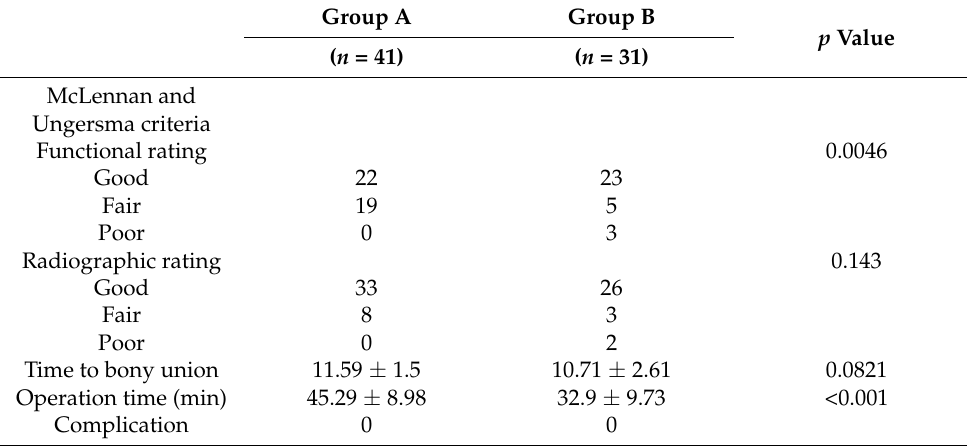
Table 3. Comparison of outcomes between two groups according to use of the lag screw. Group